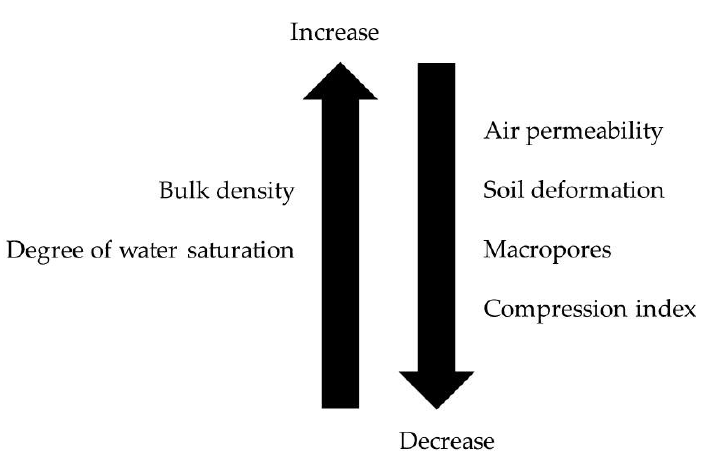
Figure 10. Scheme showing alterations on bulk density and degree of water saturation, with changes on physical and compressive properties and air permeability.